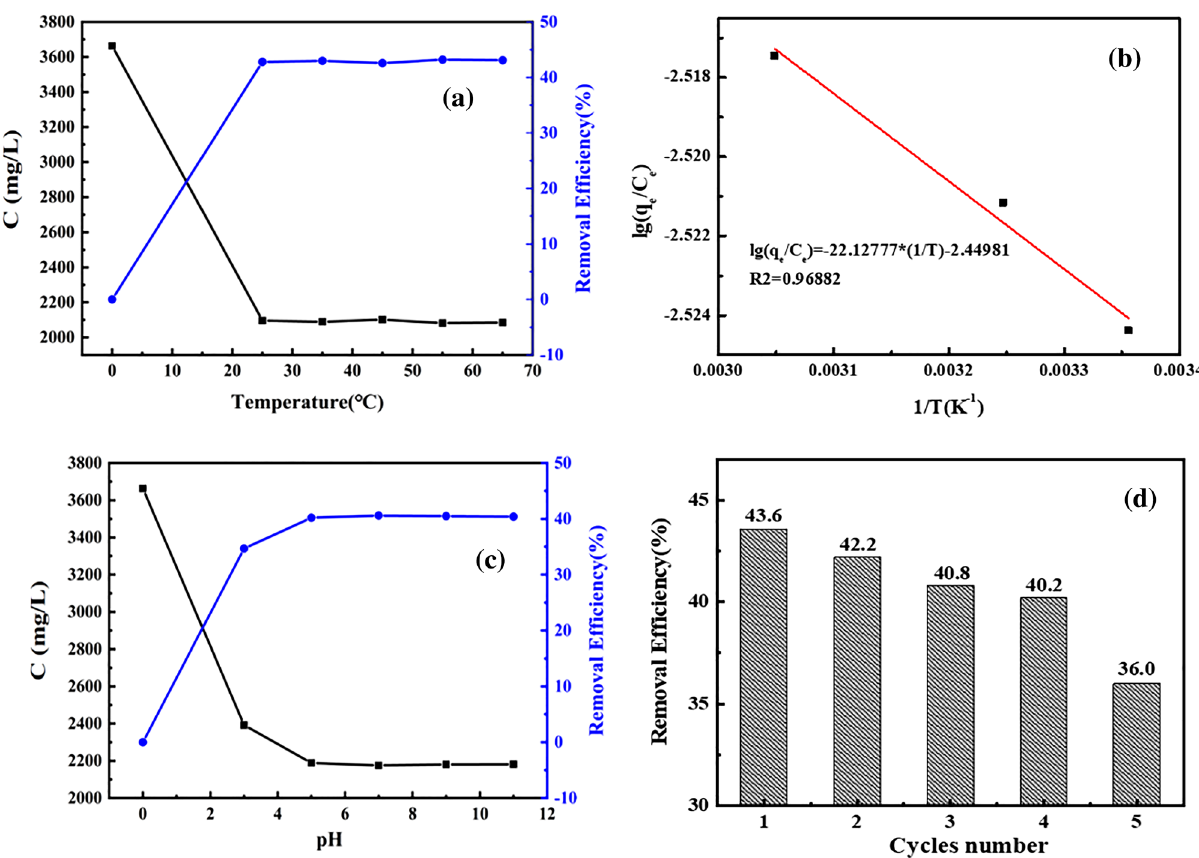
Figure 7. Variation curve of adsorption capacity and removal rate with temperature ( a ); thermodynamic curve ( b ); variation curve of adsorption capacity and removal rate with pH ( c ); COD removal efficiency by hydrophobic adsorbent after five cycles of regeneration ( d